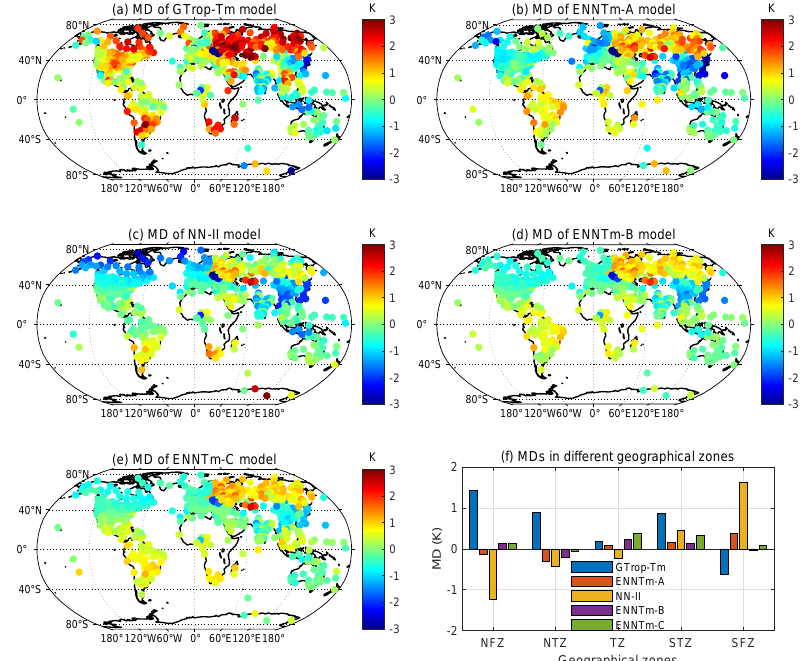
Figure 8. The scattergram of MD (mean deviation) for ( a ) GTrop-Tm model; ( b ) ENNTm-A model; ( c ) NN-II model; ( d ) ENNTm-B model and ( e ) ENNTm-C model at each test IGRA station; and ( f ) their statistics in different geographical zones validated by radiosonde data during 2017 and 2018.